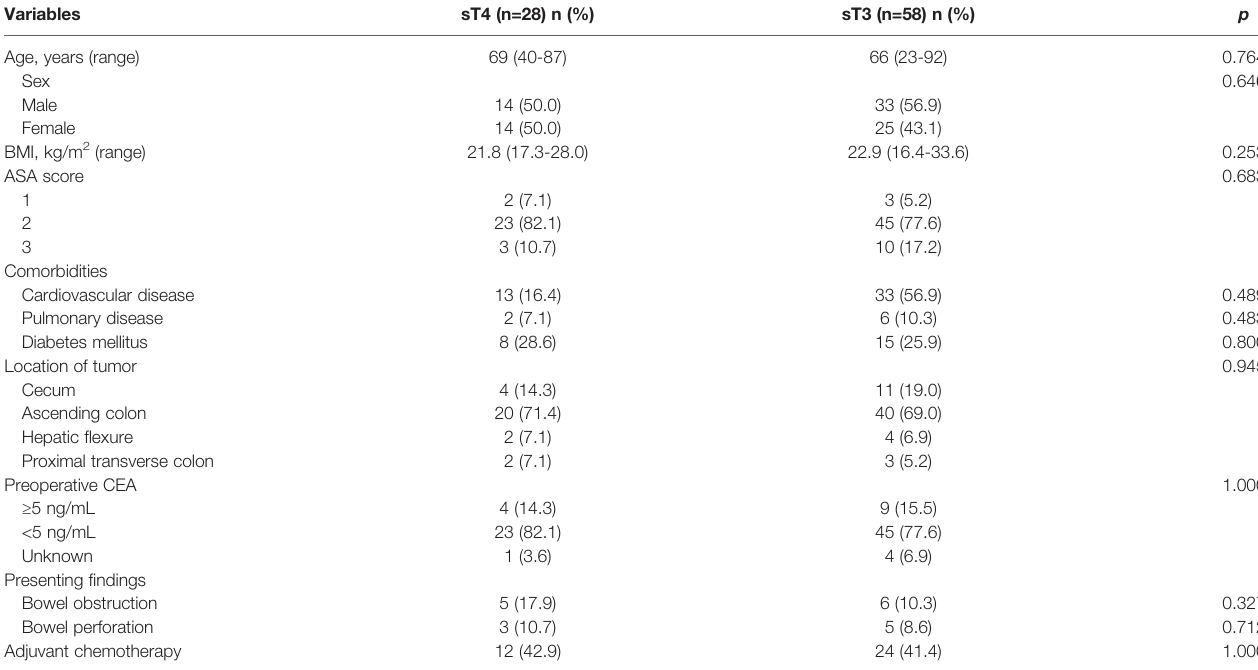
TABLE 2 | Baseline patient demographics.